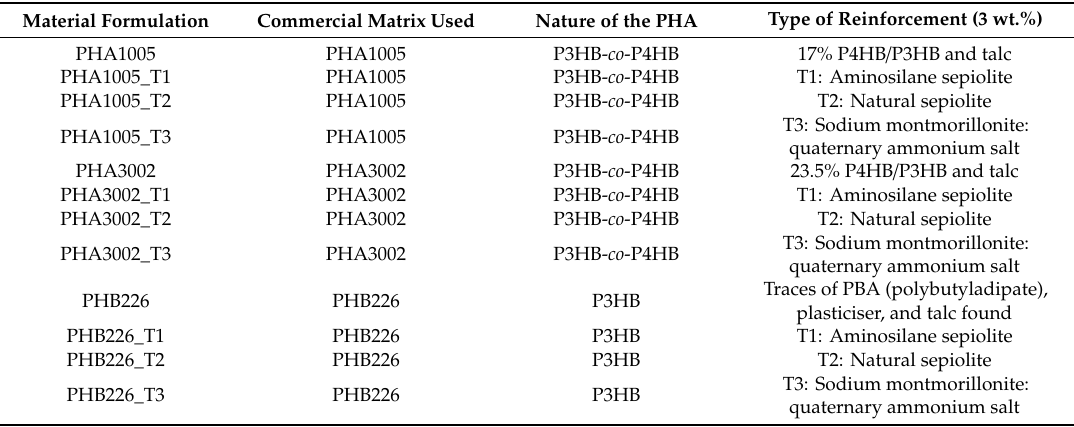
Summary of material formulations based on poly(3-hydroxybutyrate)